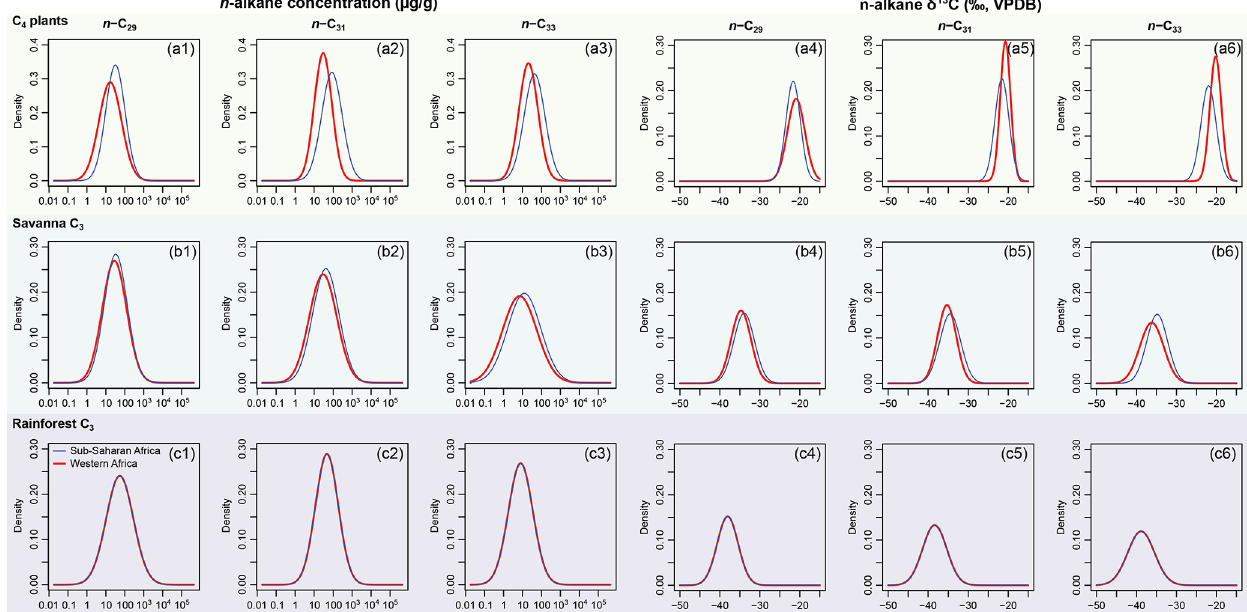
Figure 4. Comparisons of prior distributions based on wester African plant samples (thick red curves) vs. sub-Saharan African plant samples (thin blue curves). The three left-most columns illustrate n -alkane concentrations. The three right-most columns illustrate n -alkane δ 13 C values.